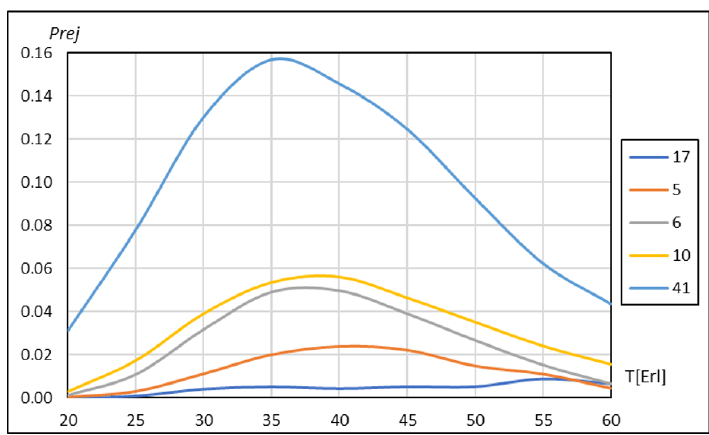
Figure 4. Results of simulations in reference to graph 122.